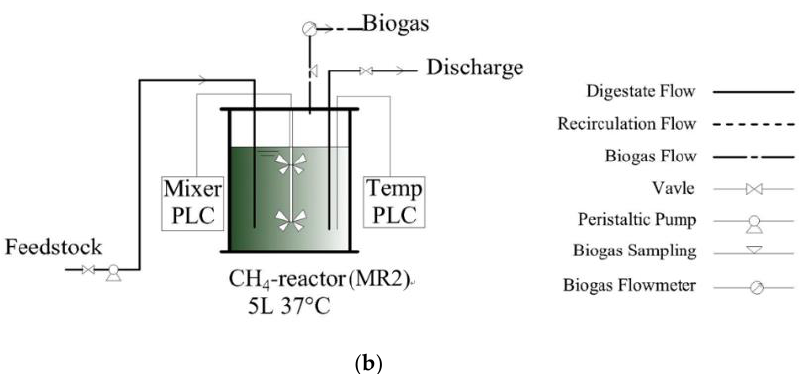
Figure 1. Schematic diagrams of experimental apparatus. ( a ) Two-stage fermentation process; ( b ) Figure 1. Schematicdiagramsofexperimentalapparatus. ( a )Two-stagefermentationprocess; ( b )single-stage single-stage fermentation process. fermentation process.